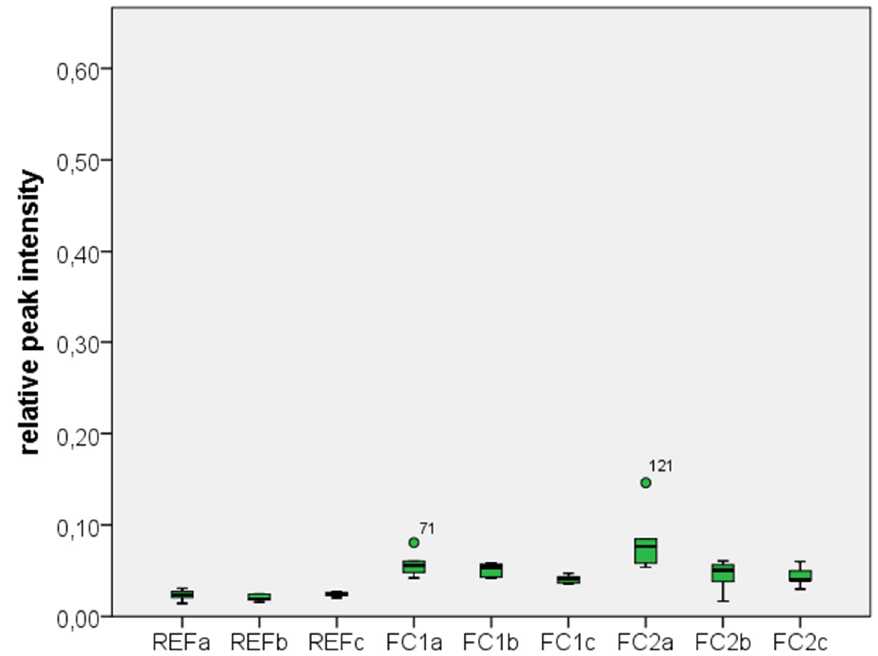
Figure 2. Relative peak intensity of silicone (group codes see Table